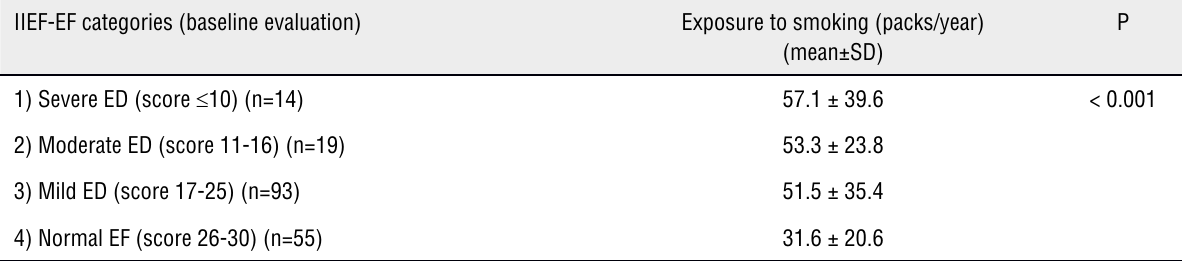
Table 4 - Comparison of the IIEF categories according to exposure to smoking. IIEF-EF categories (baseline